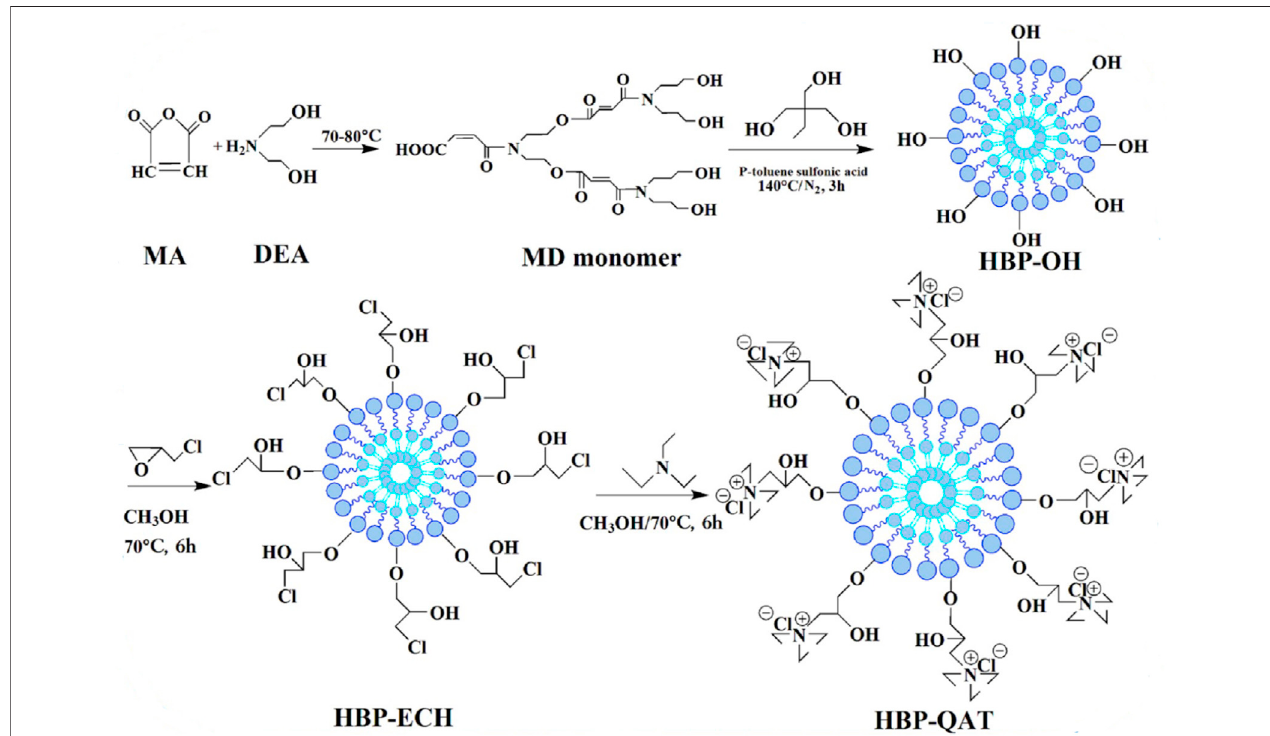
FIGURE 14 | Synthesis route of HBP-QAT (Feng et al.,